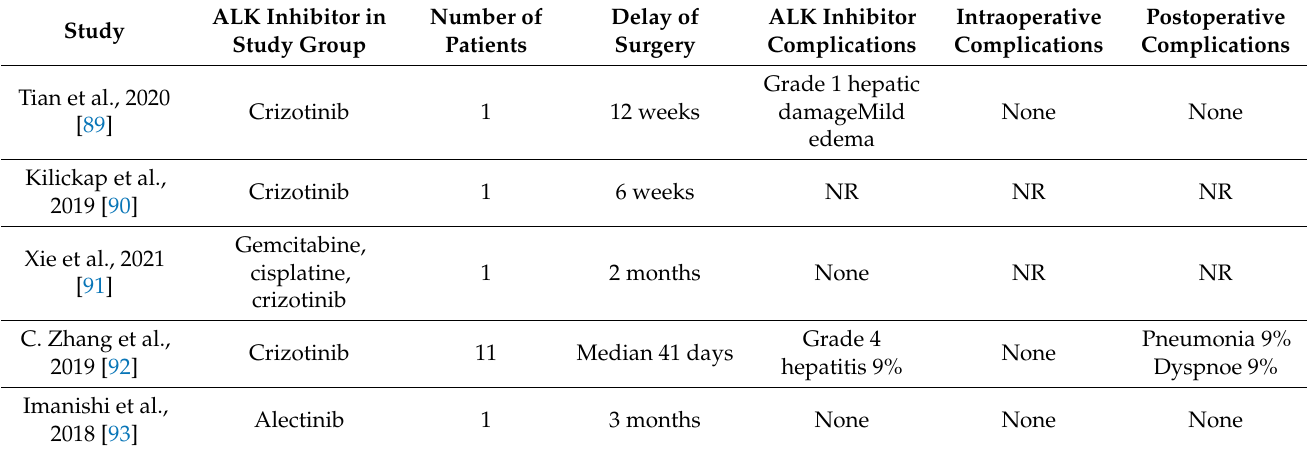
Table 2. Toxicities of neoadjuvant ALK inhibitors reported in the literature. ALK, anaplastic lymphoma kinase; NR, not